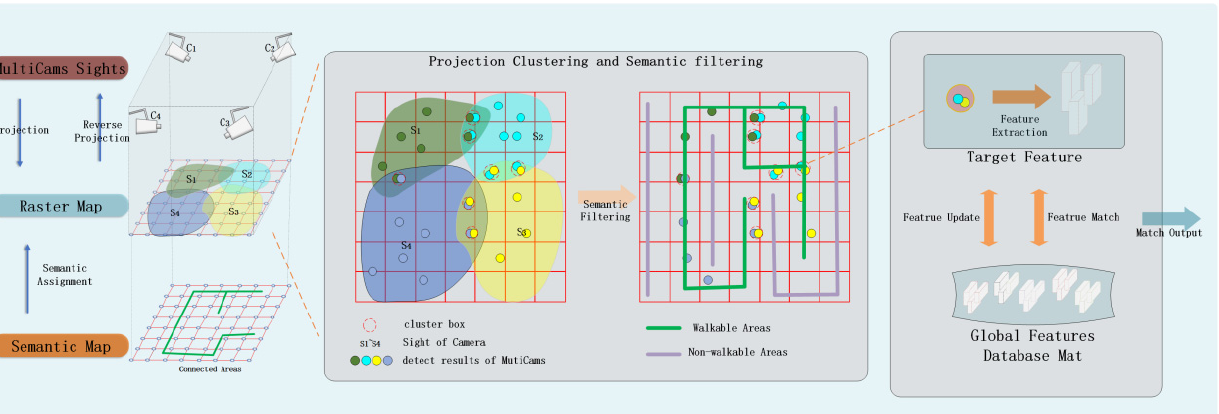
Figure 5. Walkability semantic information.